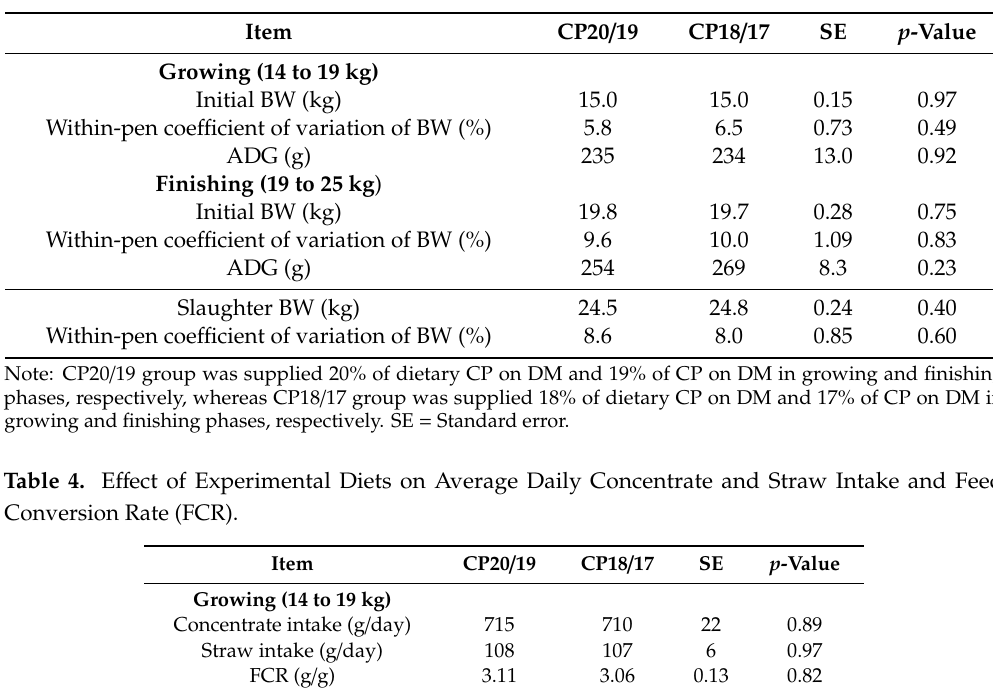
Table 3. E ff ect of Experimental Diets on Body Weight (BW) and Average Daily Gain (ADG).